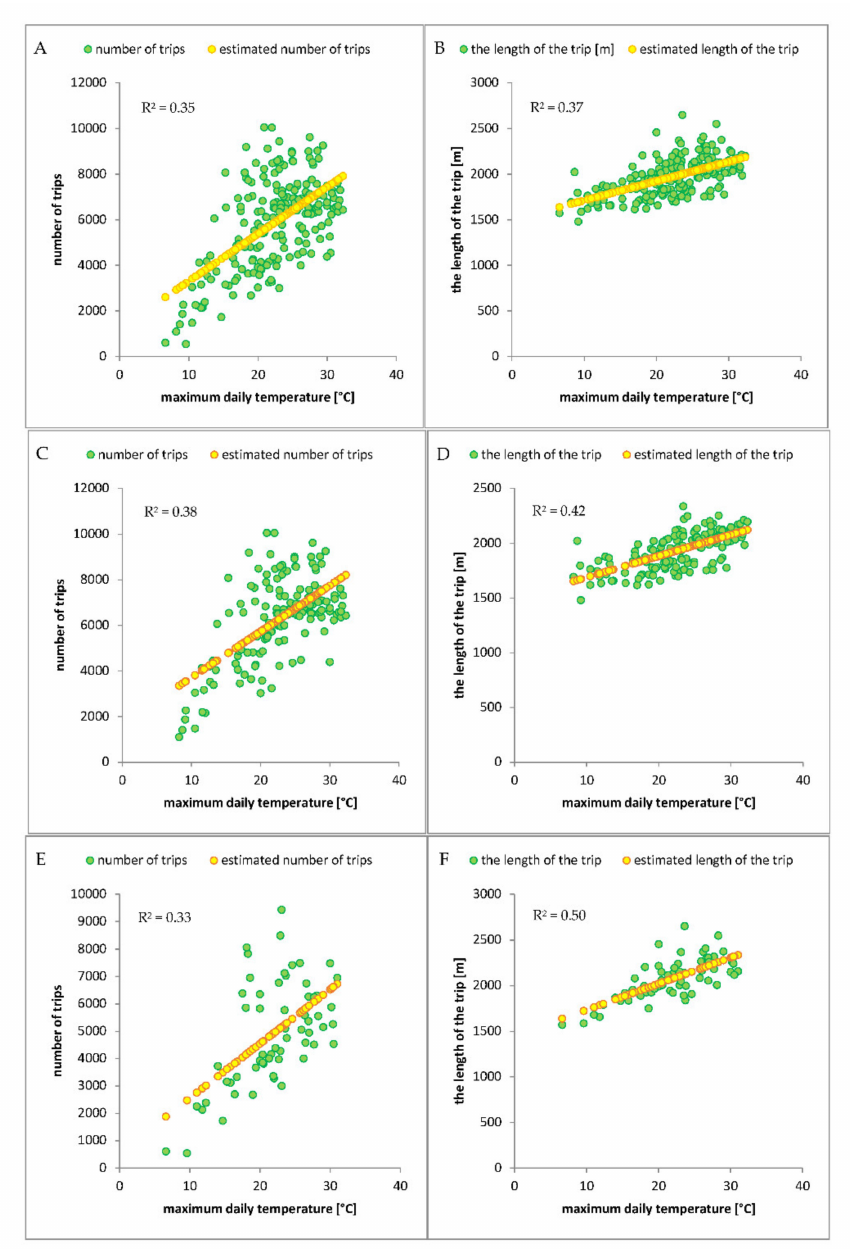
Figure 5. Correlation between the maximum daily temperature and the number ( A , C , E ) and length ( B , D , F ) of trips taken by users of the ŁPB scheme throughout the week ( A , B ) on working days ( C , D ) and on weekends ( E , F ) in Ł ó d´z in 2018. Source: own elaboration based on the Ł ó d´z City Hall and archival data of the Institute of Meteorology and Water Management at the National Research